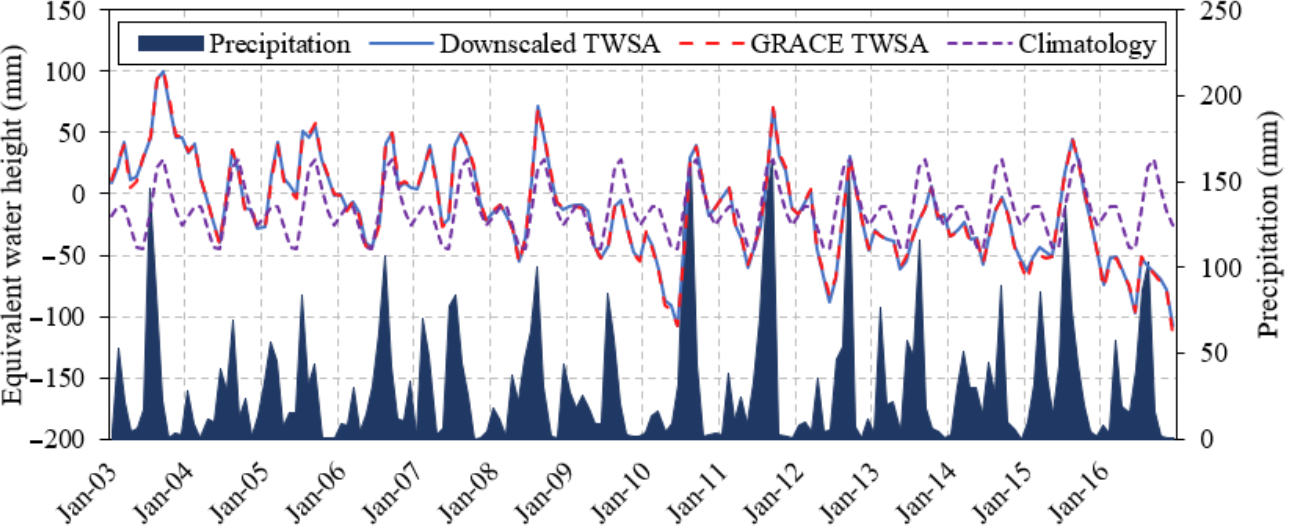
Figure 5. Time series of GRACE-derived and downscaled TWSA, precipitation, and